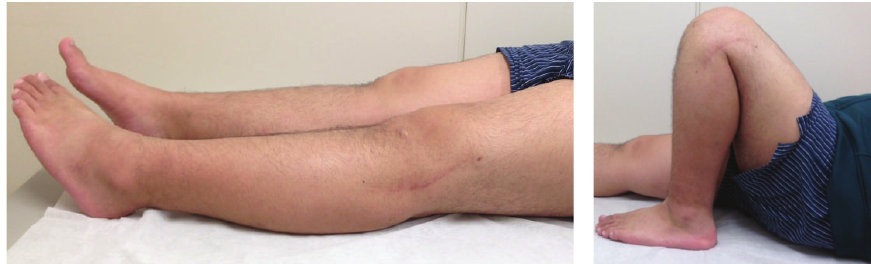
Figure 5: At the final follow-up, 31 months after the injury, there was excellent knee range of motion (5 ∘ –0 ∘ –145 ∘ ), stability of the knee, and muscle